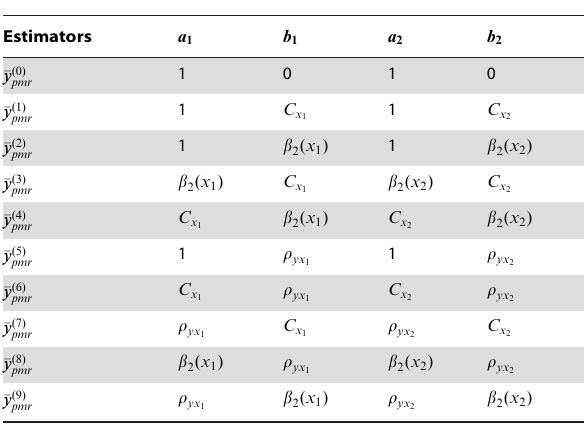
Table 2. The suitable choices of constants a 1 , b 1 , a 2 and b 2